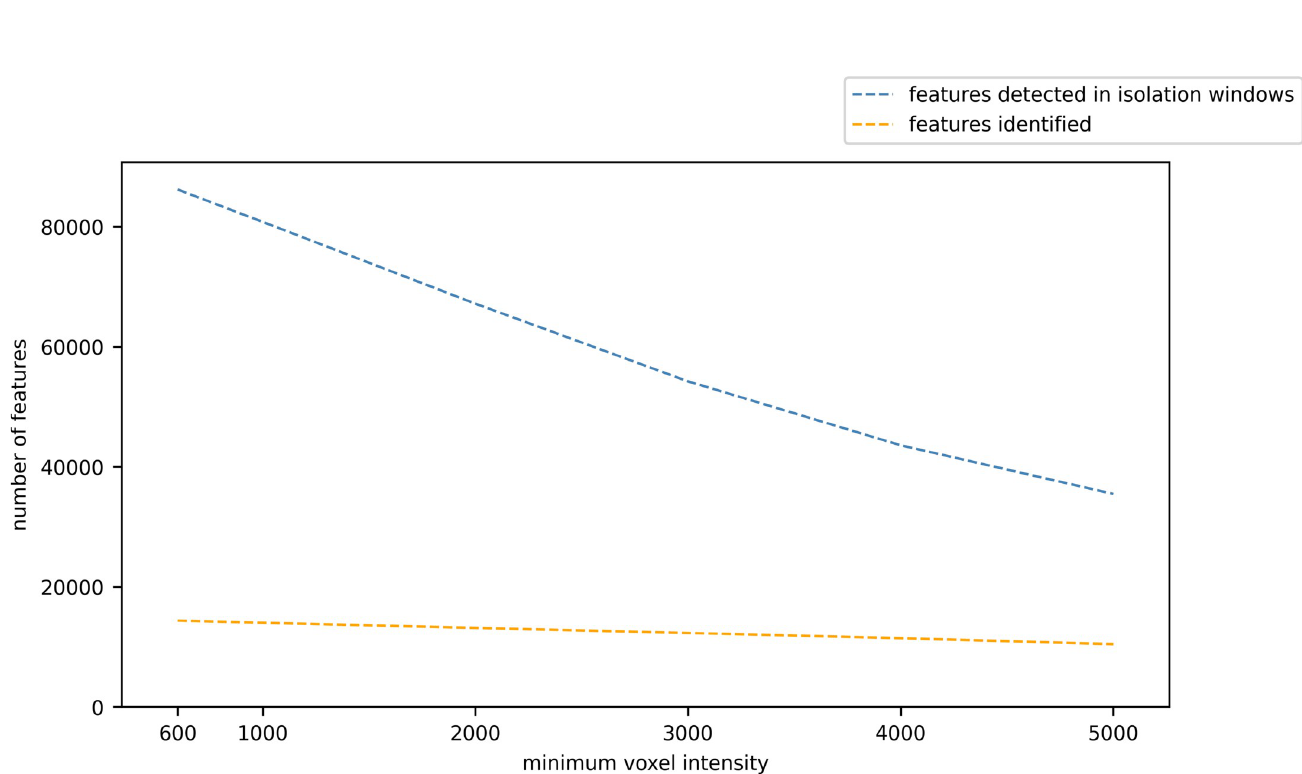
Fig 9. Number of features detected in isolation windows and identified versus minimum voxel intensity.